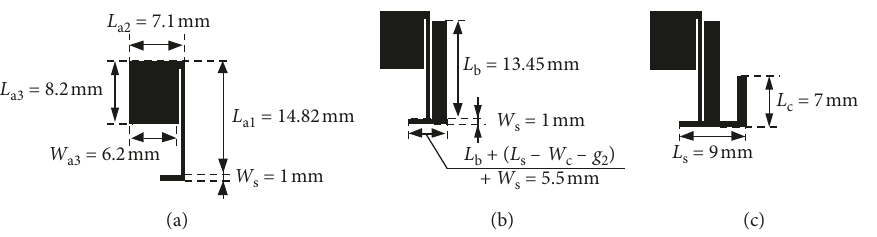
Figure 3: The radiatingelements: (a)afoldedopenstub(Antenna1),(b)afoldedopenstubanda longL-shapedstrip(Antenna2),(c)afoldedopen stub and long and short L-shaped strips (Antenna3).